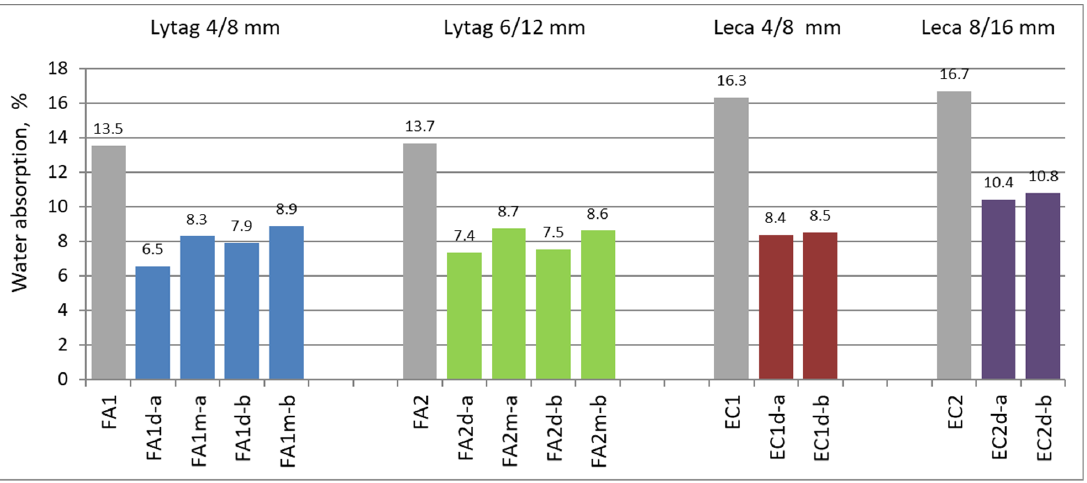
Figure 6. Mean water absorption of concretes with plain and impregnated lightweight aggregates.